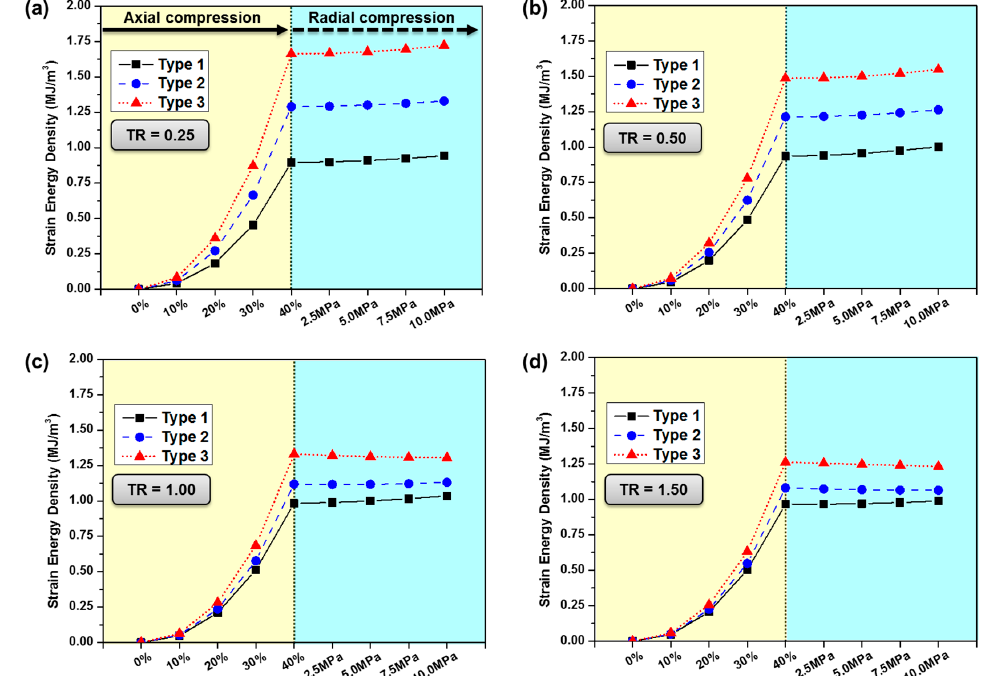
Figure 9. Changes in average strain energy density stored in the UMS model with axial and radial compressions. The yellow area indicates axial compression from 10% to 40% of the compression ratio during assembly. The blue area represents radial compression from 2.5 to 10.0 MPa of the internal pressure during operation: ( a ) TR = 0.25; ( b ) TR = 0.50; ( c ) TR = 1.00; and ( d ) TR = 1.50.